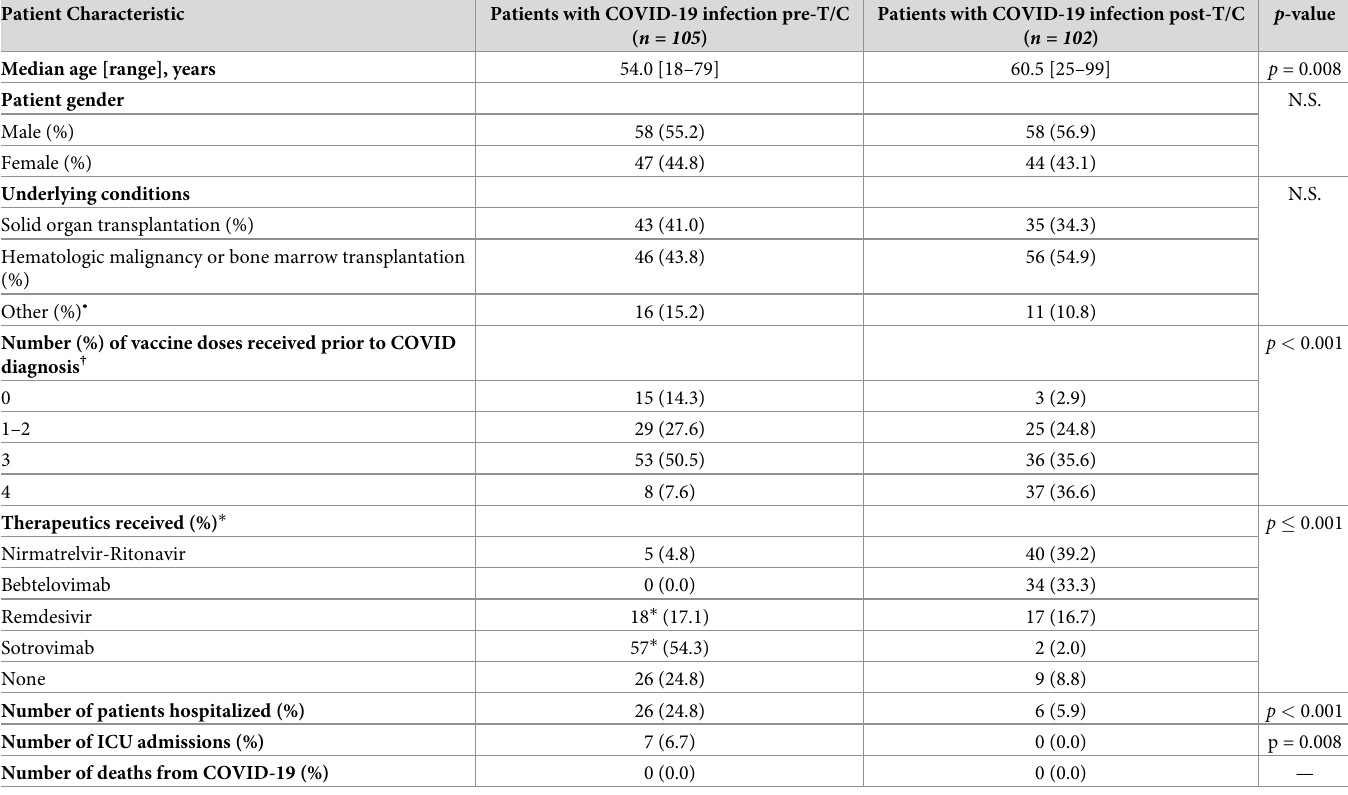
Table 1. Characteristics of recipients of tixagevimab-cilgavimab (T/C) who developed COVID-19 infection between December 19, 2021 and July 31, 2022 when Omicron was the dominant circulating variant. Characteristics of T/C recipients who were infected prior to receiving T/C (pre-T/C) are compared with characteristics of T/C recipients who were diagnosed with COVID after having received any dose of T/C